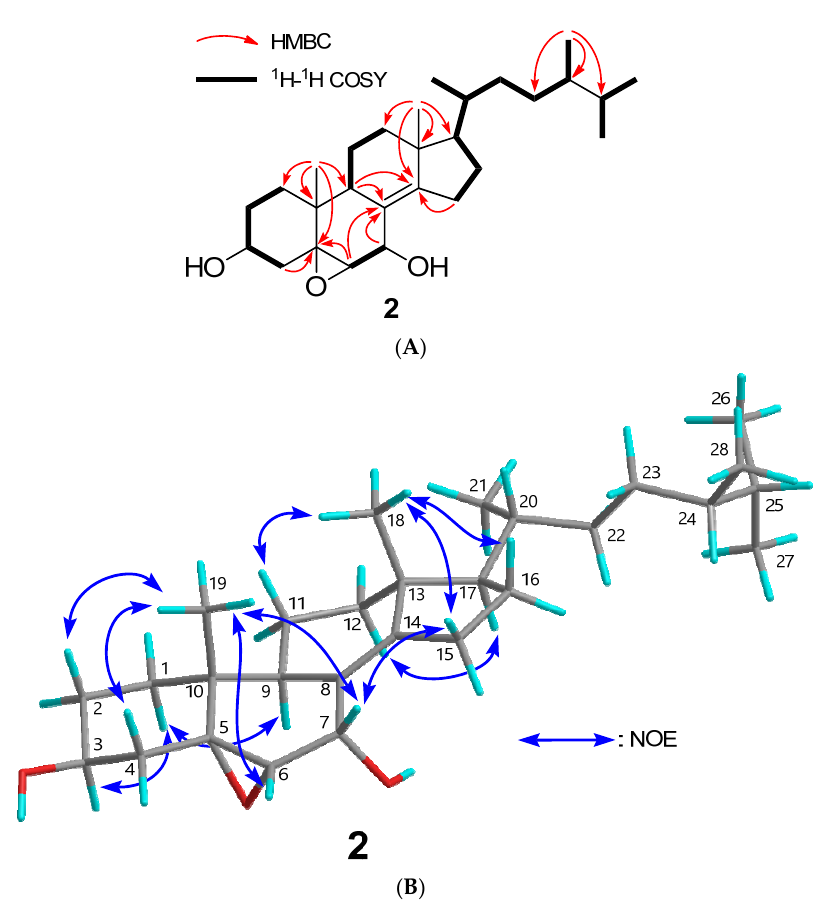
Figure 3. Structure determination of compound 2 . ( A ) Key HMBC and 1 H- 1 H COSY correlations of compound 2 ; ( B ) Key NOE correlations of compound 2 . The atoms of C, H, and O were shown in grey, aqua, and red, respectively.